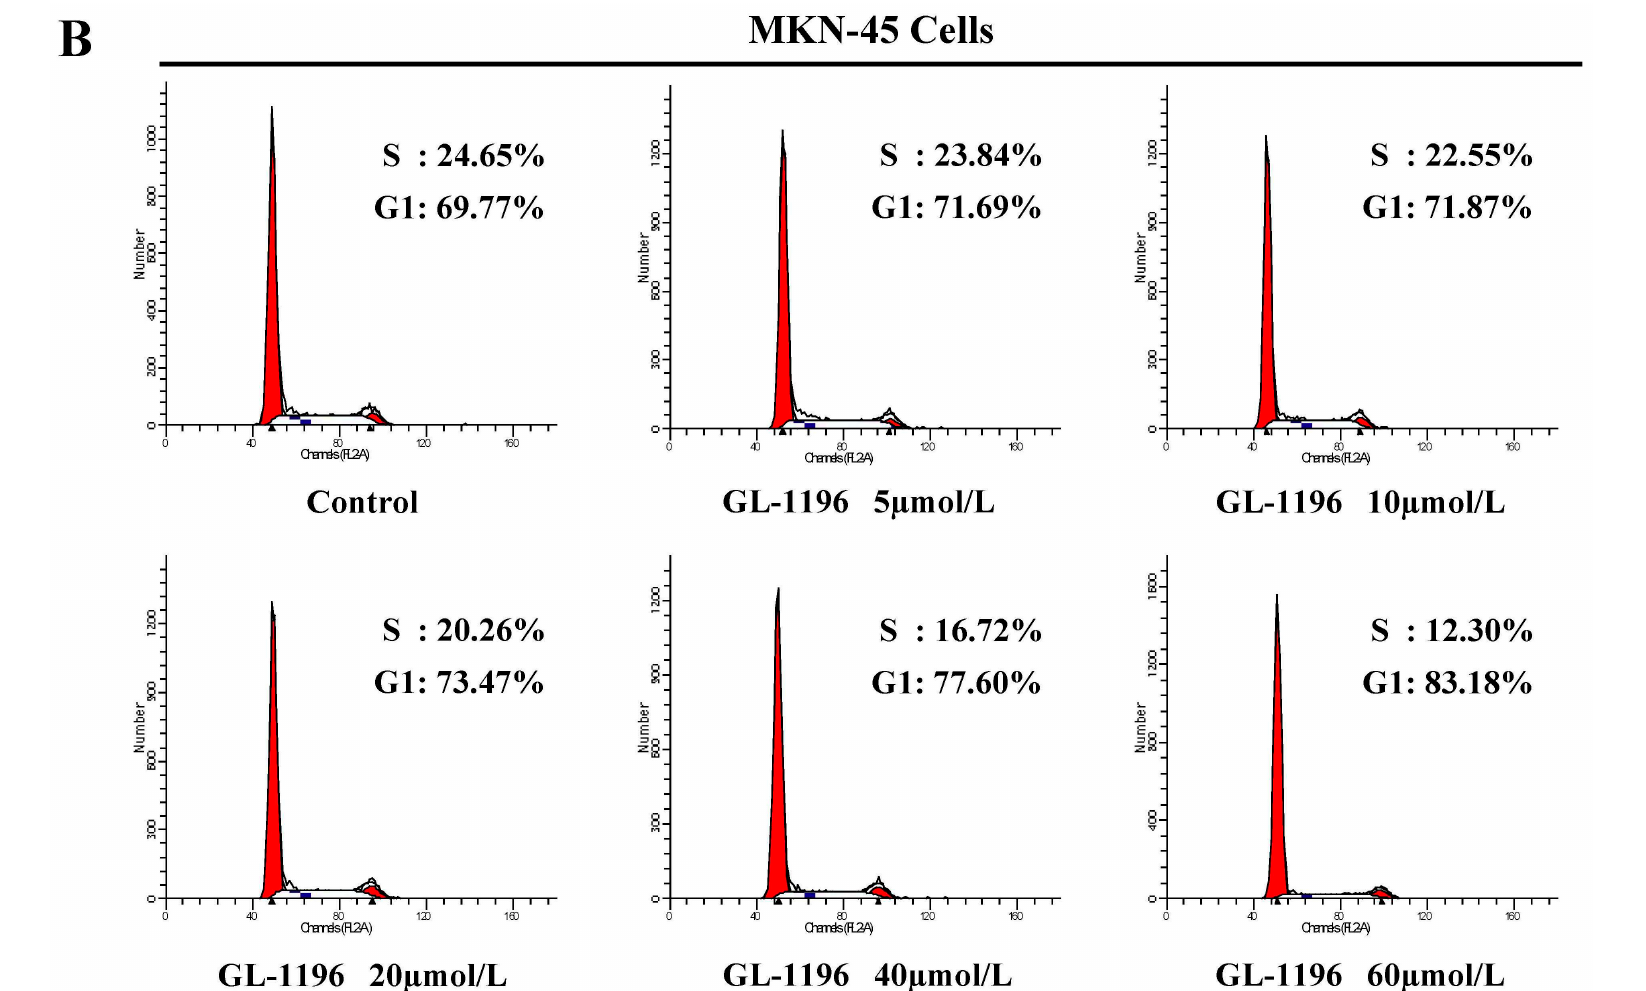
Figure 2. GL-1196 suppresses the transition of SGC7901 ( A ) and MKN-45 ( B ) cells from G1 to S phase.